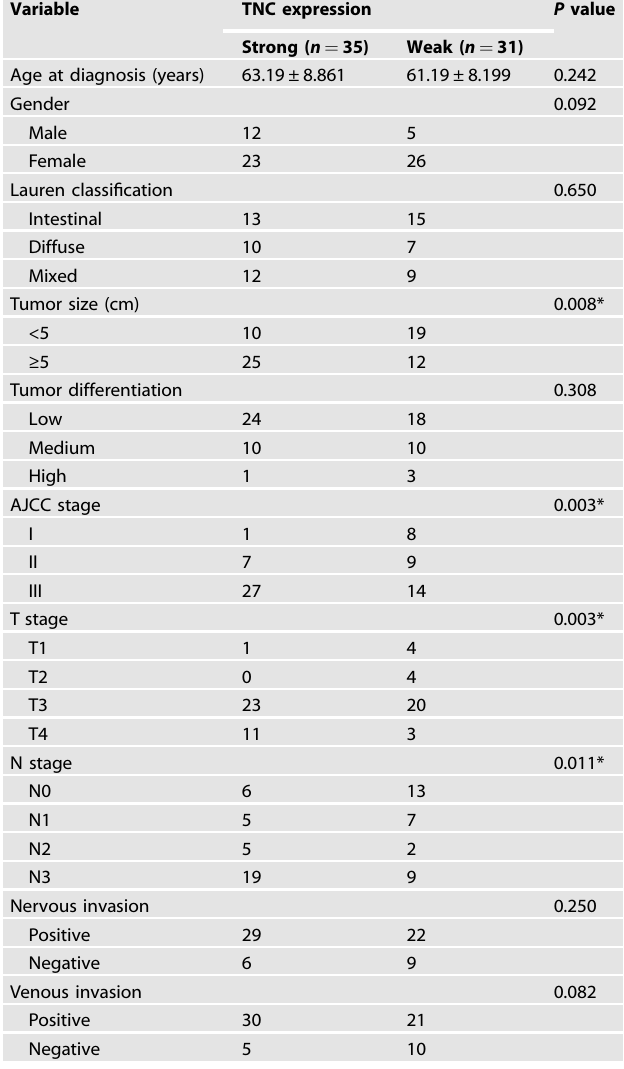
Table 2. Clinicopathological information of patients with gastric